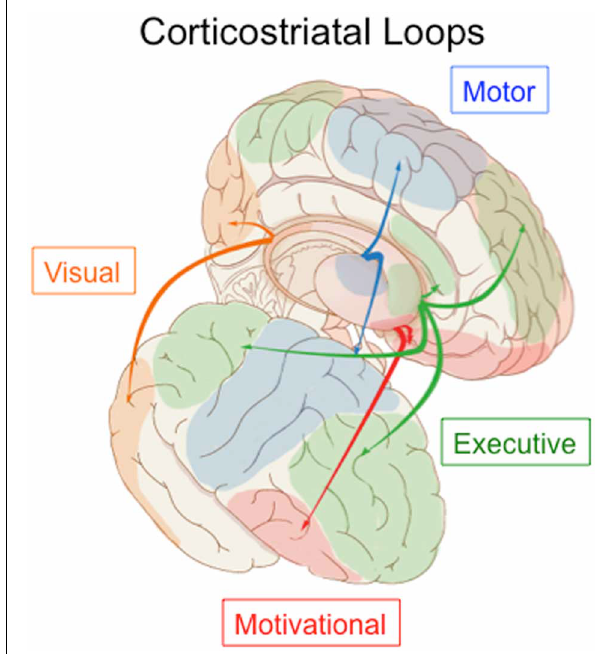
FIGURE 3 | Parcellation of the corticostriatal system into four loops. The visual loop, indicated in orange, connects extrastriate and inferior temporal visual cortex to the tail of the caudate nucleus. Figure based on information in Lawrence et al. (1998) and Seger